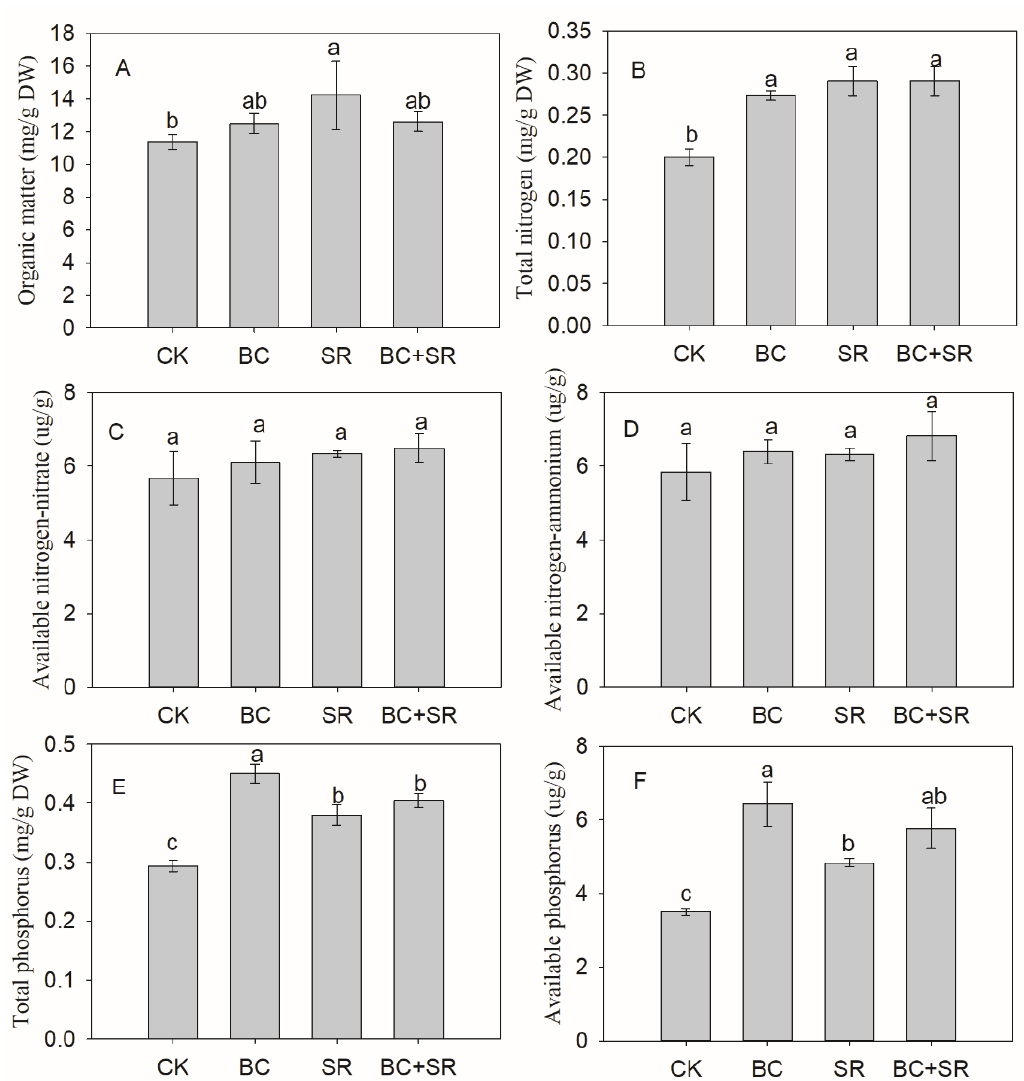
Figure 5. Effect of different soil types on soil organic matter ( A ), total nitrogen ( B ), available nitrogen ( C , D ), total phosphorus ( E ), and available phosphorus ( F ). CK, sand only; BC, biochar; SR, sand and soft rock; BC + SR, sand, biochar, and soft rock. Data are shown in mean ± SD. Different letters indicate significant differences ( p < 0.05).